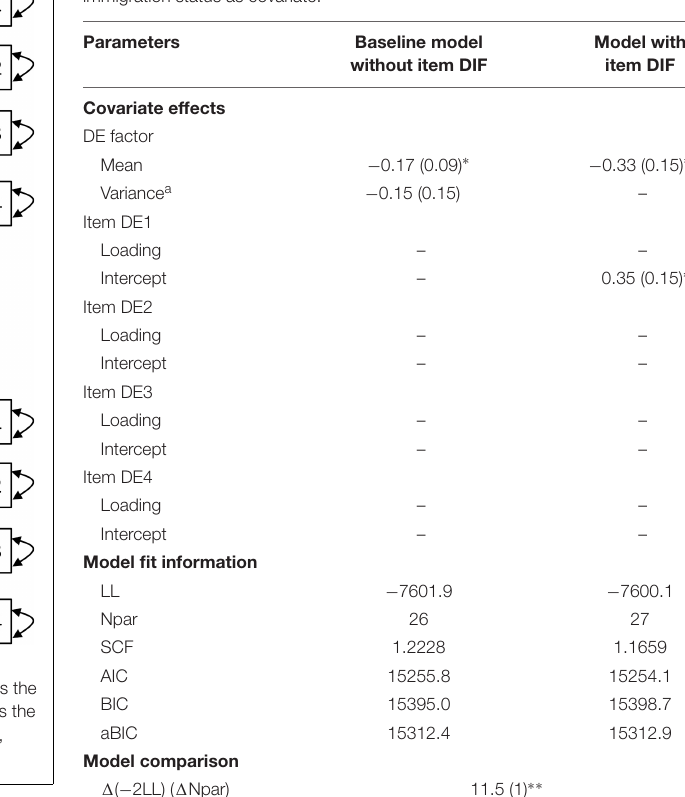
TABLE 3 | Unstandardized parameter estimates from the MNLFA models with immigration status as